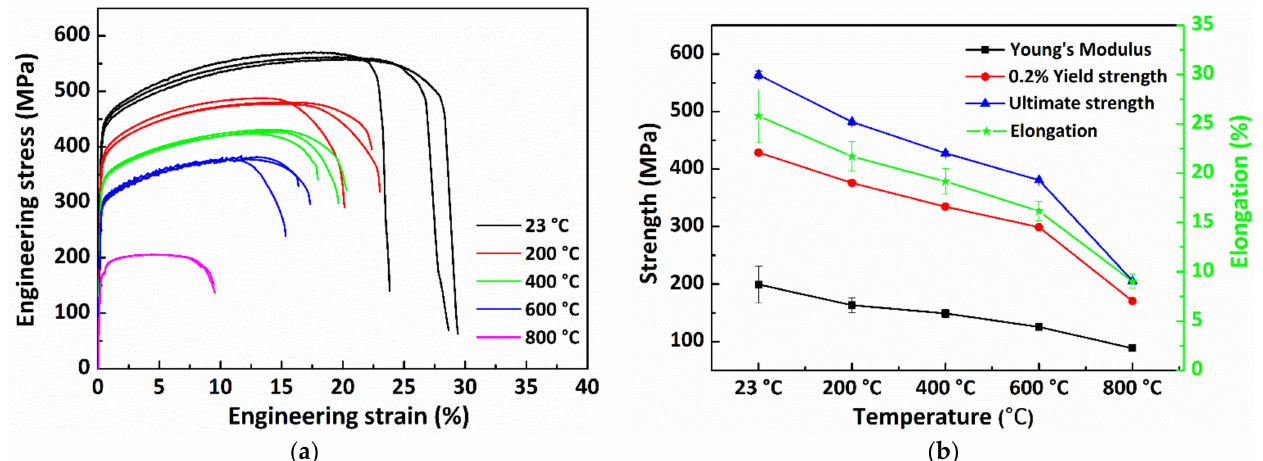
Figure 10. ( a ) Engineering stress-strain curves at different temperature conditions, and ( b ) Tem- perature dependence of Young’s modulus, yield strength, ultimate strength, and elongation for DED-SS316L xy-orientated specimens.